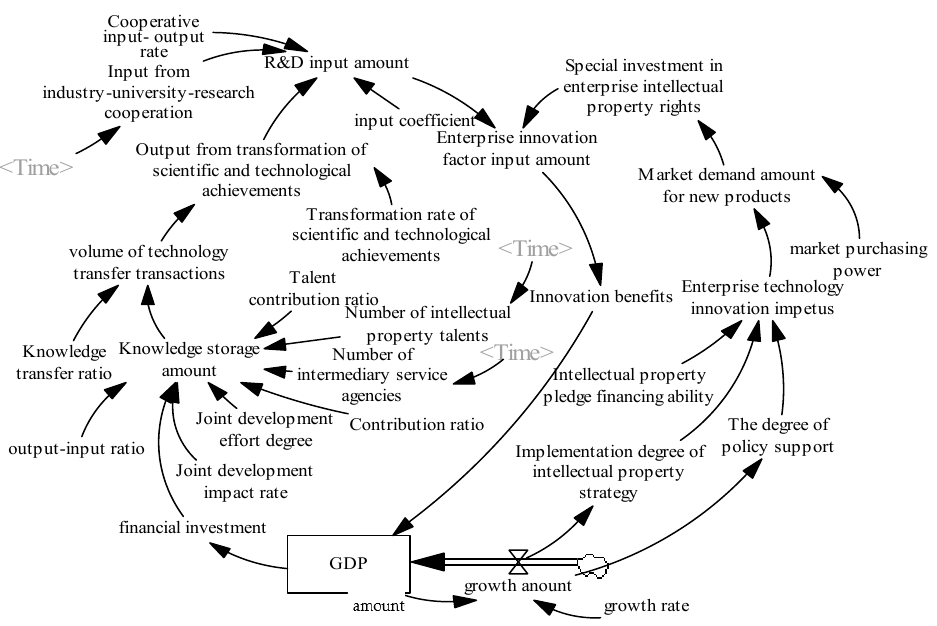
Figure 1. System dynamic flow of IPR influence on regional economic development.